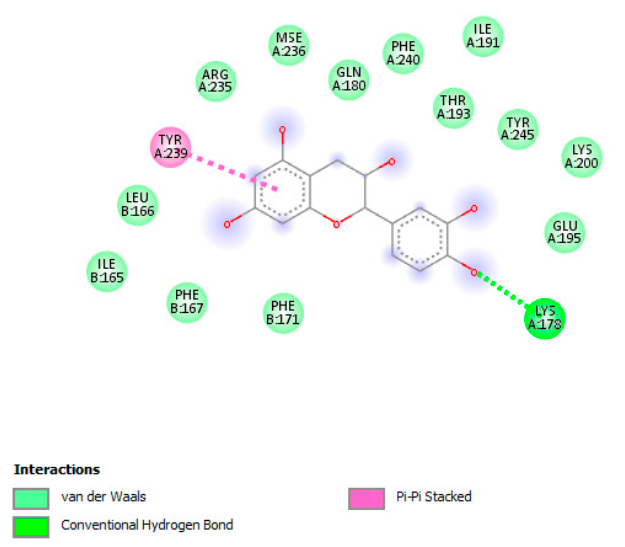
Figure 6. Putative interaction between catechin and S. aureus β -lactamase (ORF259) (PDB:3ESH). Free energy of binding ( Δ G) and affinity (Ki) are − 7.8 kcal/mol and 1.9 µM, respectively.